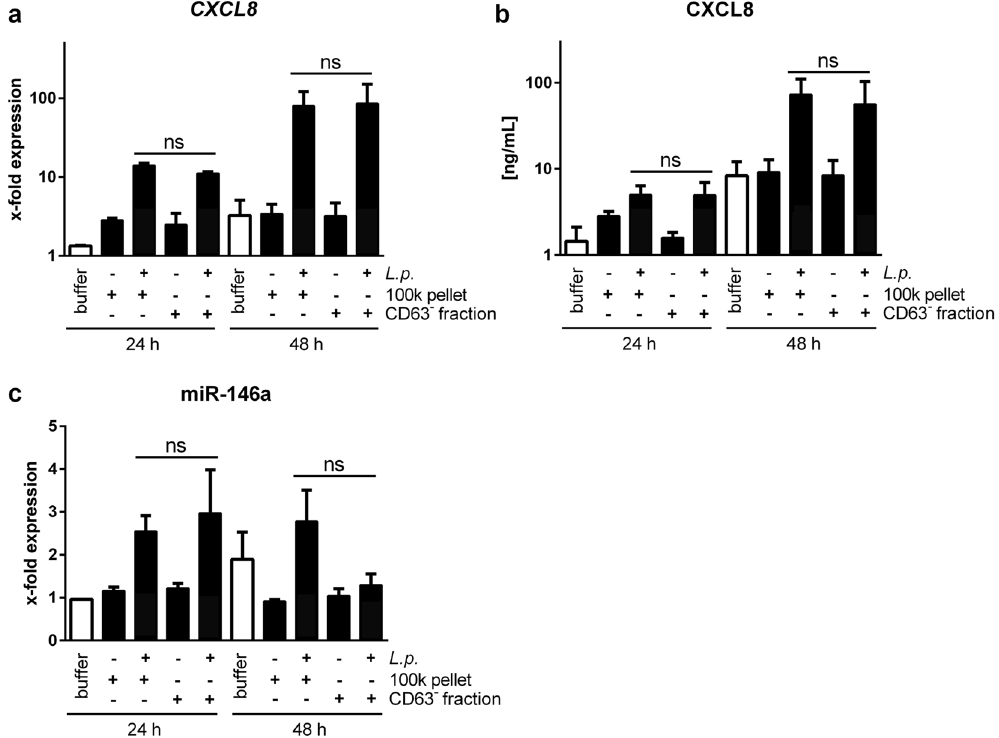
Figure 6. THP-1 cells respond to the CD63-negative EV fraction. ( a , c ) Pro-inflammatory THP-1 response depends on OMVs. 100 k pellets from L . pneumophila -infected or control THP-1 cells were generated. CD63-positive exosomes were removed by immunoprecipitation. Entire 100 k pellet or unbound EVs (CD63 − fraction) were used for stimulation of THP-1 cells for 24 and 48 h. Expression of CXCL8 ( a ), CXCL8 secretion ( b ) and expression of miR-146a ( c ) were analysed. Data are shown as mean + SEM of three independent experiments. ns: not